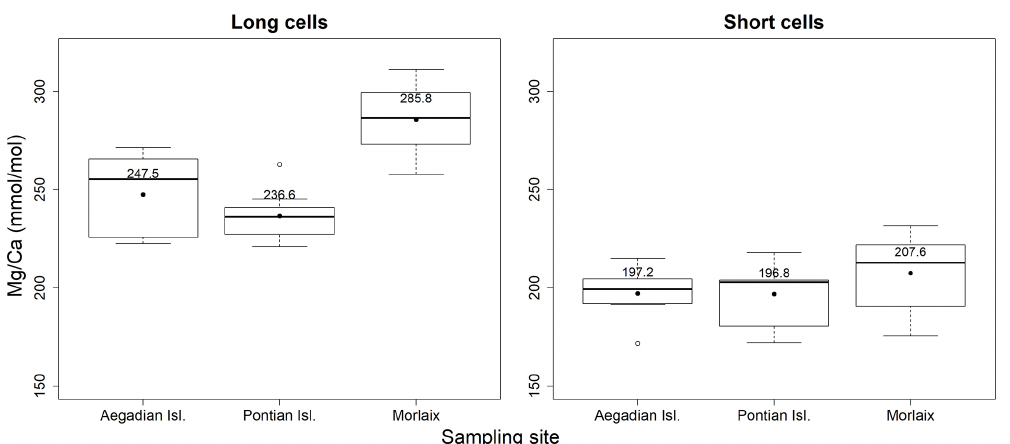
Figure 5. Box plots of the statistical tests performed to evaluate the differences of Mg / Ca in the long and short cells of L. corallioides collected at different sampling sites. The horizontal black lines indicate the median values. The black dots and the numbers inside the plot indicate the mean values.